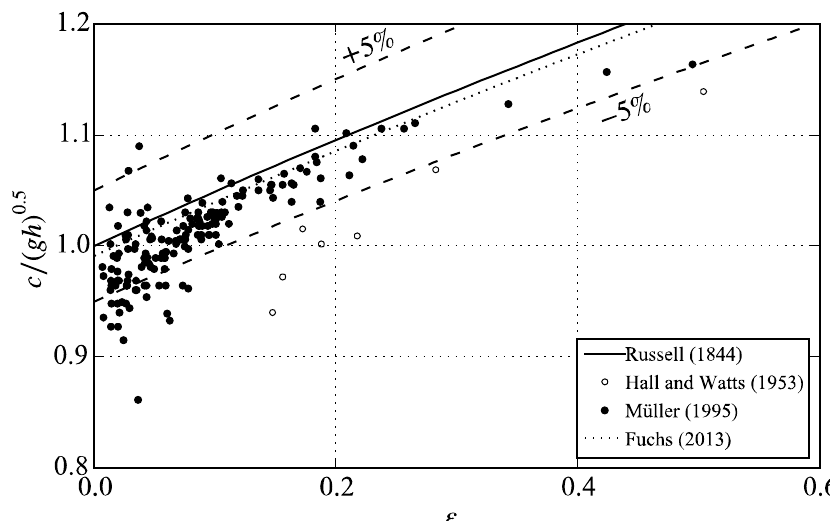
Figure 2. Relative wave crest celerity c /( gh ) 0.5 versus relative wave amplitude ε from data sources